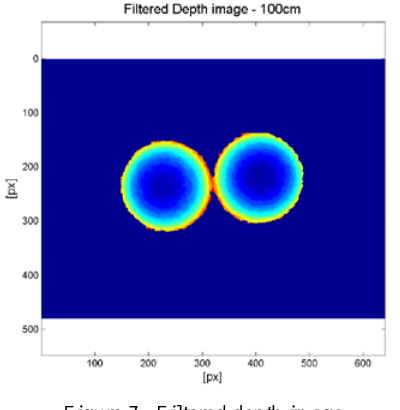
Figure 7. Filtered depth image